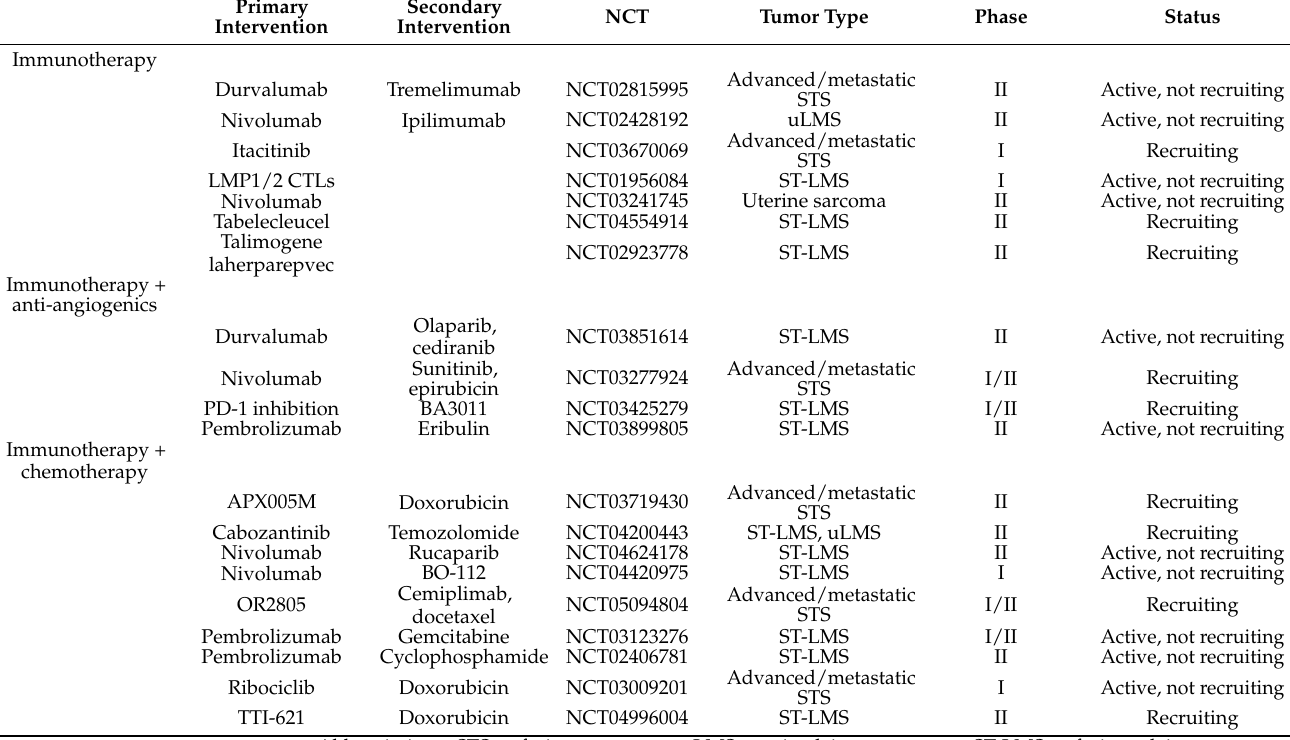
Table 3. List of active and recruiting trials examining immune-checkpoint blockade in